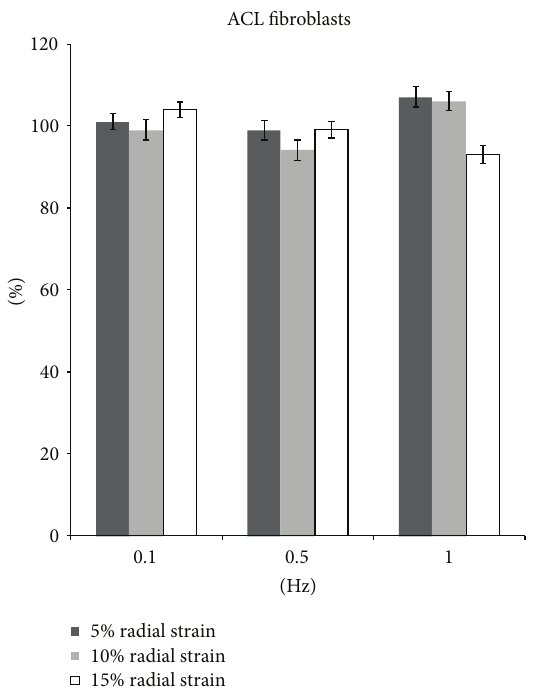
Figure 7: The proliferation of fibroblasts after radial stretch stimu- lation.